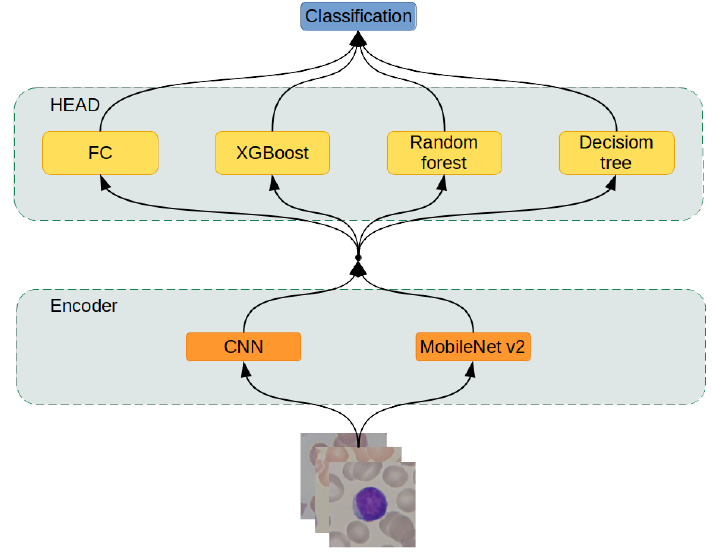
Figure 5. Hybrid artificial intelligence system